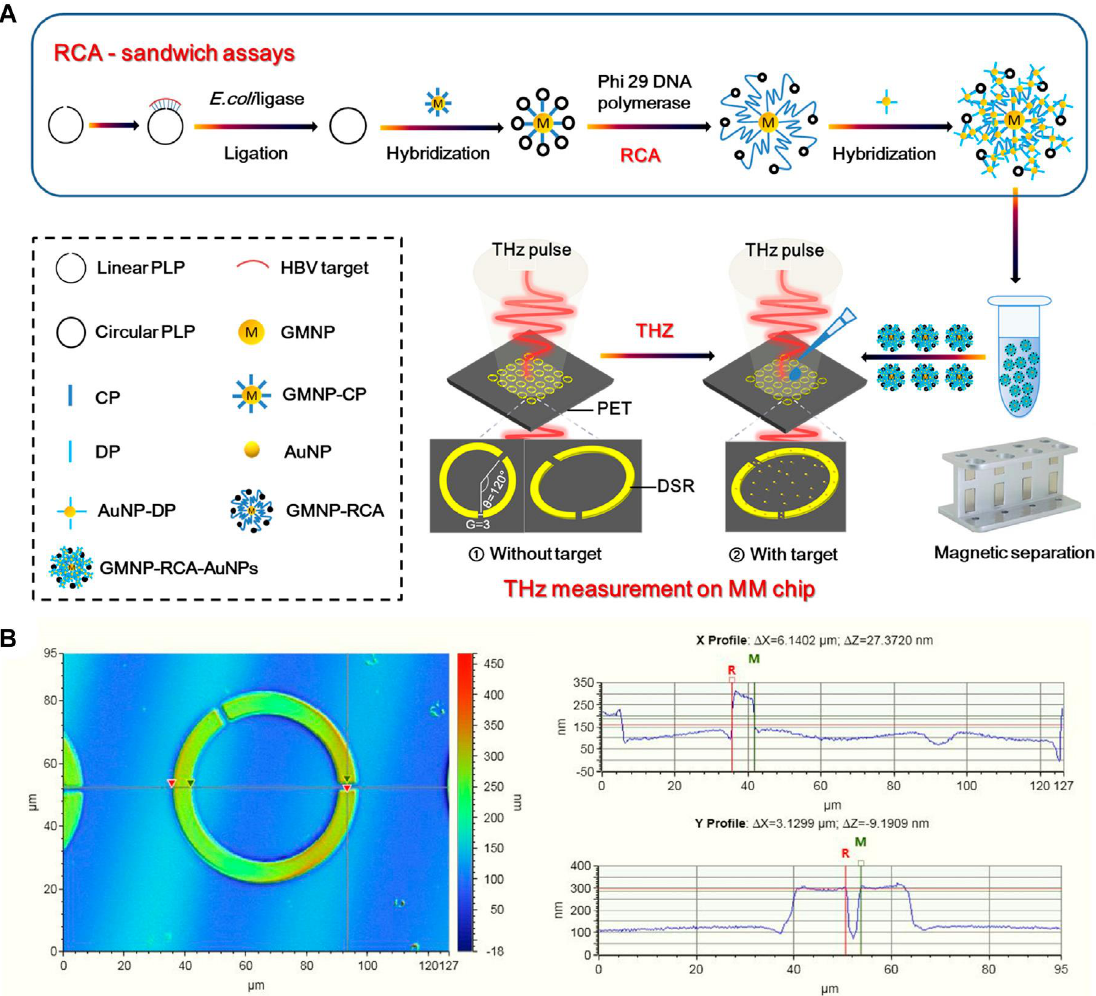
Figure 9. A visual summary of the THz biosensing strategy, adopted by Li et al. for HBV DNA sensing. ( A ) Graphical description of the THz biosensor chip for HBV DNA detection based on the GMNPs-RCA-AuNPs sandwich assay. To increase the LOD, the metamaterial metal split-ring (SR) resonators are composed of double asymmetric splits fabricated on an ultra-thin PET substrate with low intrinsic loss. The DSR sensor features strong sensing characteristics due to the resonance shift loaded with the dielectric material. ( B ) Characterization of the DSR cell. Reprinted from [114].